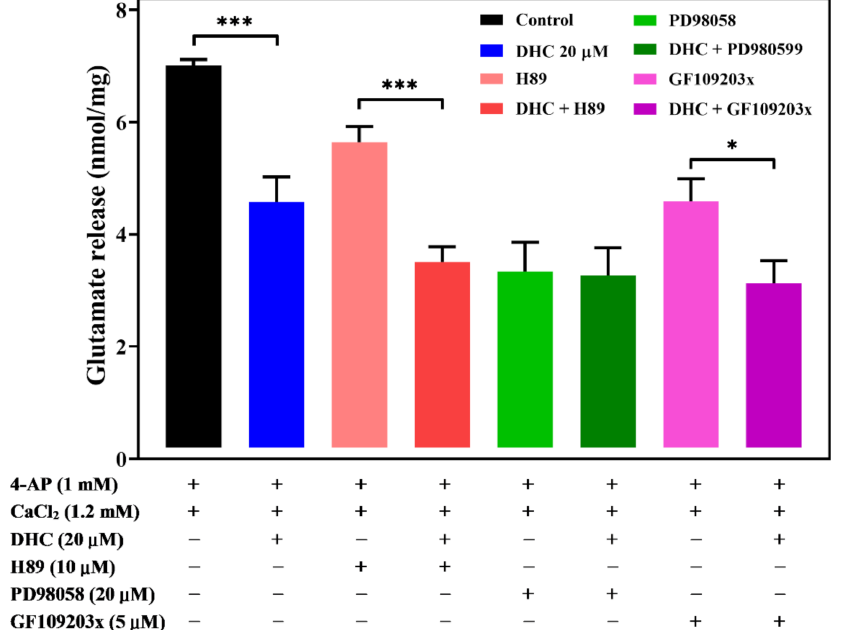
Figure 6. DHC-mediated inhibition of glutamate release is modulated by ERK1/2. Quantitative anal- ysis of glutamate release by depolarizing stimuli (4-AP 1 mM) when synaptosomes were incubated with or without 20 µ M DHC, 100 µ M PKA inhibitor H89, 50 µ M ERK kinase inhibitor PD98059, or 10 µ M PKC inhibitor GF109203X. Data are the means ± SEM. *** p < 0.001 versus the control group or the H89-treated group, * p < 0.05 versus the GF109203X-treated group ( n =